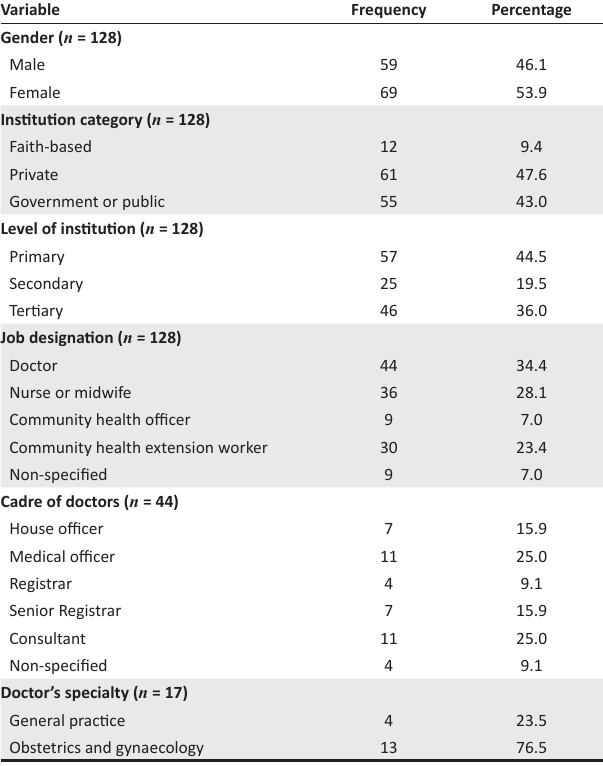
TABLE 1: General characteristics of antenatal healthcare providers in healthcare facilities in Jos North, Plateau state, Nigeria, August to September 2019.